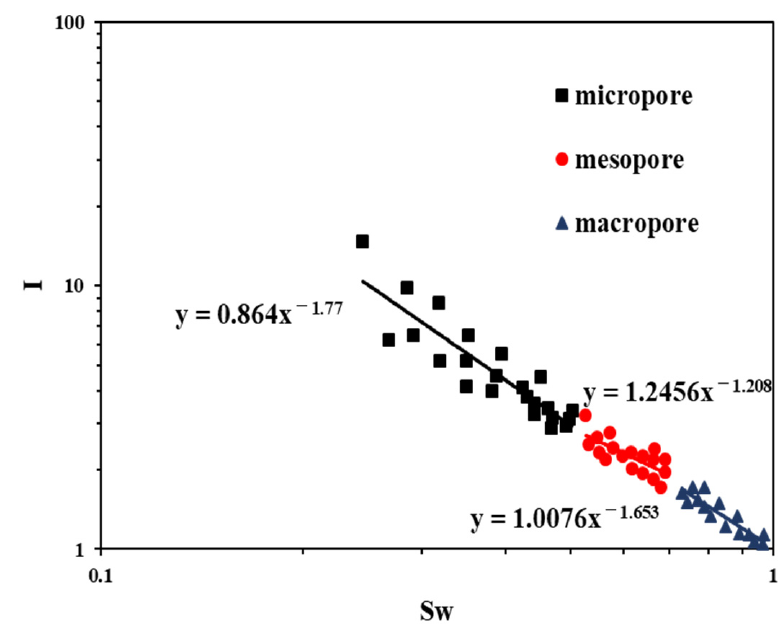
Figure 23. Relationship between resistivity index and saturation.